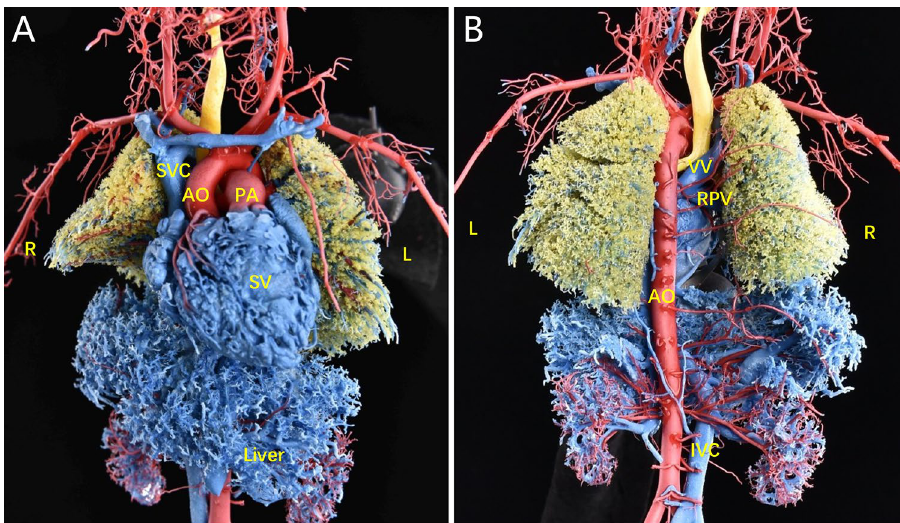
Figure 9. Findings from the postnatal cardiovascular cast. ( A , B ) A single ventricle with double outlet, and left aortic arch were observed, with the common PV trunk returning to the right superior vena cava via the vertical vein.